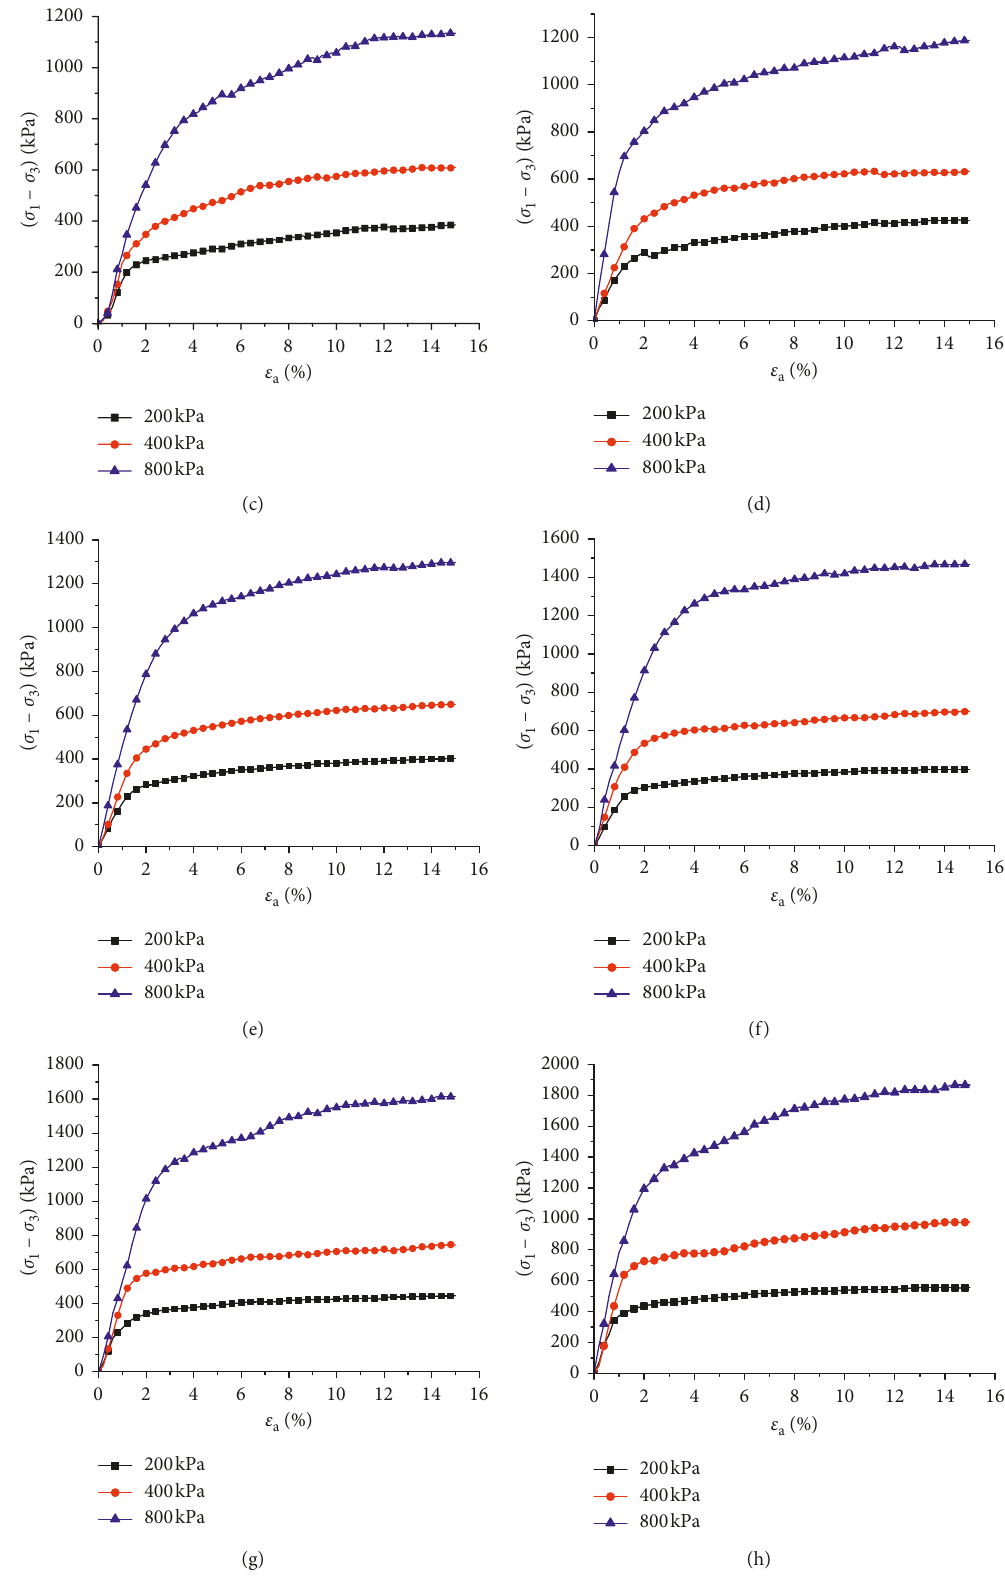
Figure 7: Stress-strain curves of samples with different rock contents: (a) 0%, (b) 10%, (c) 20%, (d) 30%, (e) 40%, (f) 50%, (g) 60%, and (h)